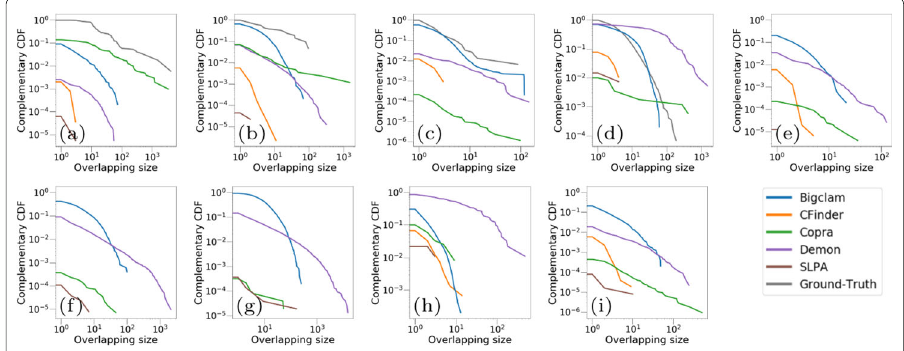
Fig. 30 Overlapping size identified by the methods considering the real-world networks: a Amazon; b DBLP; c LiveJournal; d Youtube; e CAGrQc; f CAHepPh; g CitHepTh; h Email; i